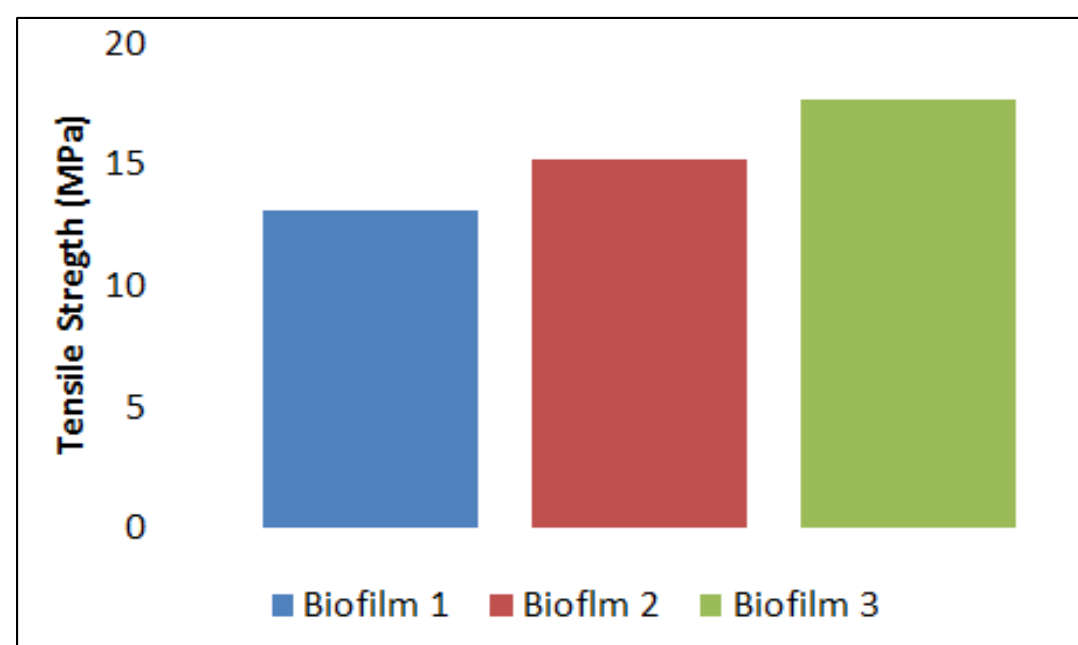
Figure 6. Comparison of the mechanical properties of each biofilm produced based on variations in chitosan.